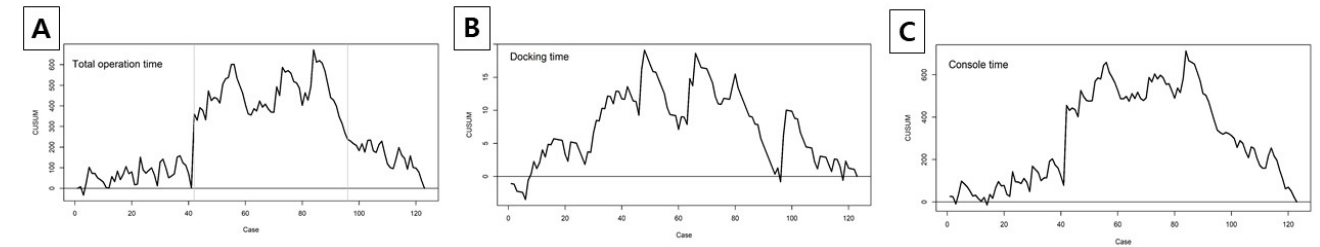
Figure 2. Cumulative sum (CUSUM) chart of single-site robotic surgery. ( A ) Operation time. ( B ) Docking time. ( C ) Console time.